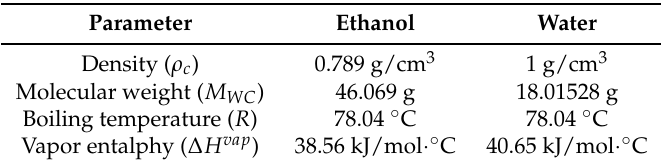
Table 3. Parameters of the Ethanol–Water mixture.